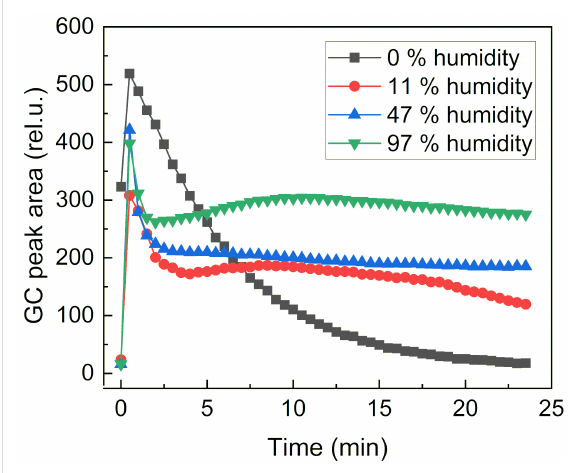
Figure 8: Evolution of the area of 5-methylfurfural released from 5-methylfurfurylimino- β -CD ( 3j ) upon time after successive extractions of the gaseous phase at different RH%